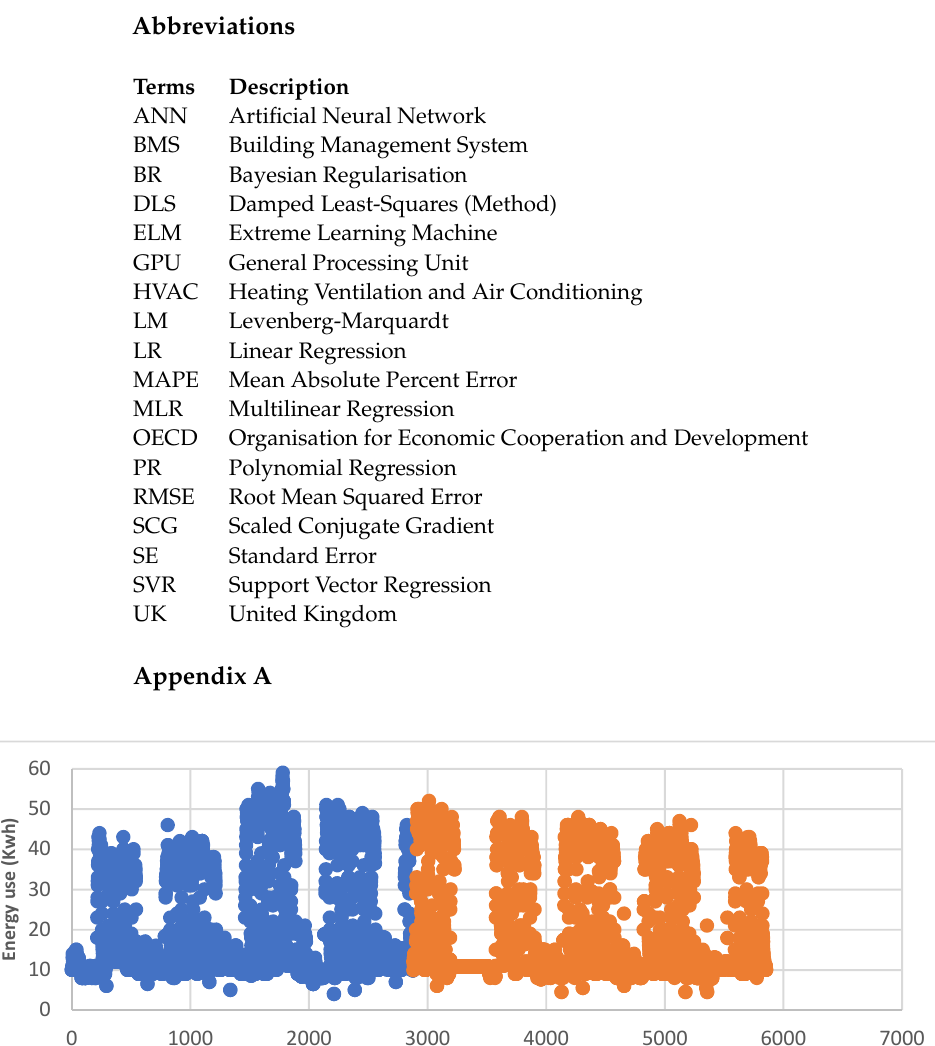
Figure A2. Building energy use over the summer training and testing period.